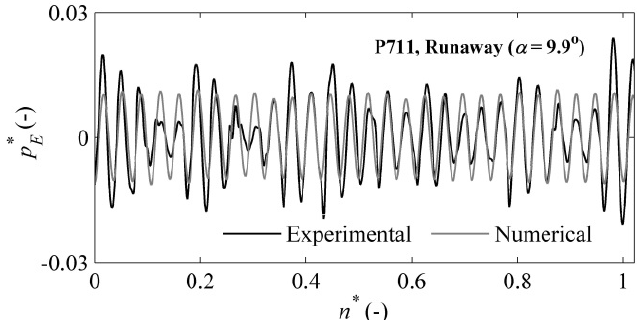
Figure 11. Instantaneous pressure fluctuations at the blade trailing edge (P71) over a complete rotation of the runner for the runaway operating point α = 9.9 ˝ ; fluctuations occur at a rotor stator interaction and guide vane passing frequency of 244.7 Hz.